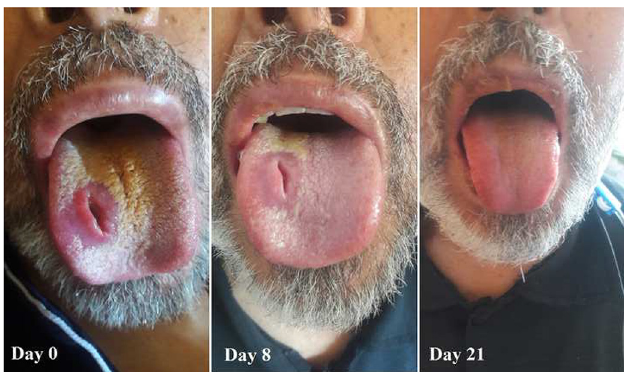
Fig. 1. Direct examination on lesions swab ( (cid:1) 400). Numerous septate mycelial fi laments with dichotomous rami fi cations and secondary fi laments disposed at acute angles. Rare arthrospores.